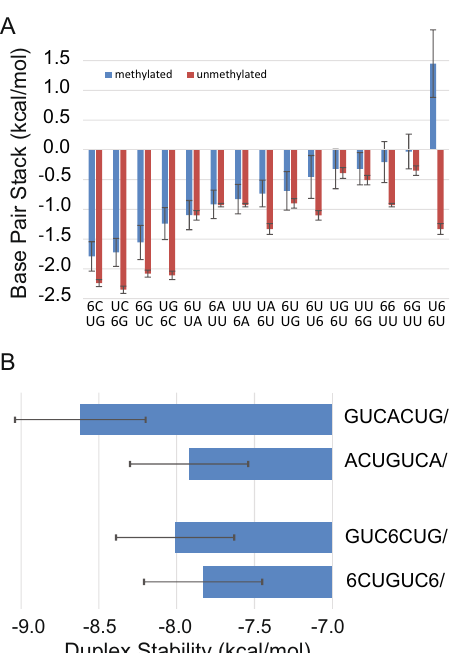
Fig. 2 A comparison of base pairing stability for m 6 A to A. A The nearest neighbor parameters for helix stacks. The position of the m 6 A is indicated by 6. The stacking parameters, determined by linear regression, are compared for methylated (blue; i.e., m 6 A-U base pairs) and unmethylated (red; i.e., A-U base pairs) sequences for analogous nearest neighbors. The unmethylated stacks (i.e., A-U base pairs) are those of Xia et al. 44 for adjacent Watson – Crick pairs and those of Chen et al. 79 for adjacent G-U pairs. Stacks with m 6 A-U pairs are generally less stabilizing than analogous stacks with A-U pairs. Uncertainty estimates are the standard errors of the regression. B Terminal m 6 A-U pairs are not destabilizing. Plotted are the duplex stabilities as folding free energy change from the linear fi t to the T M − 1 vs. ln(C T /a) plots of the optical melting data. The top two sequences (Watson – Crick paired with a complementary strand) have the same nearest neighbor stacks, but the second helix has two terminal A-U pairs 44 . This costs 0.7 kcal/mol of stability. The bottom two sequences also have the same nearest neighbor stacks, but the second has two terminal m 6 A-U pairs. Here the stability cost is 0.18 kcal/mol and not outside of the uncertainty estimate, which is approximated as 4% of the total free energy change 44 . On average, terminal A-U pairs cost 0.45 kcal/mol of stability 44 , but terminal m 6 A-U pairs are not destabilizing. Linear regression was used to fi t the nearest neighbor parameters for folding free energy change. Figure 2A shows the increments in comparison to the same stack with A-U pairs and Supplementary Table S2 provides the values. The free energy changes range from − 1.79 ± 0.25 kcal/mol to + 1.45 ± 0.57 kcal/mol. As expected based on prior optical melting experiments for duplexes with m 6 A-U pairs 34,36 , nearest neighbor stacks for methylated A-U pairs are less stable than stacks for unmethylated A-U pairs. On average, the stacks with m 6 A-U pairs are 0.4 kcal/mol less stable per methylation. There are exceptions, however; an m 6 A-U pair followed by a U-A pair is as stable as an A-U pair followed by a U-A pair ( − 1.10 kcal/mol). The most unstable stack has two m 6 A-U pairs. Like A-U pairs, when the m 6 -U pair is adjacent a G-C it is more stable than when adjacent to A-U. Also like A-U pairs, m 6 A-U pairs adjacent to G-U are less stable than those adjacent to A-U pairs.